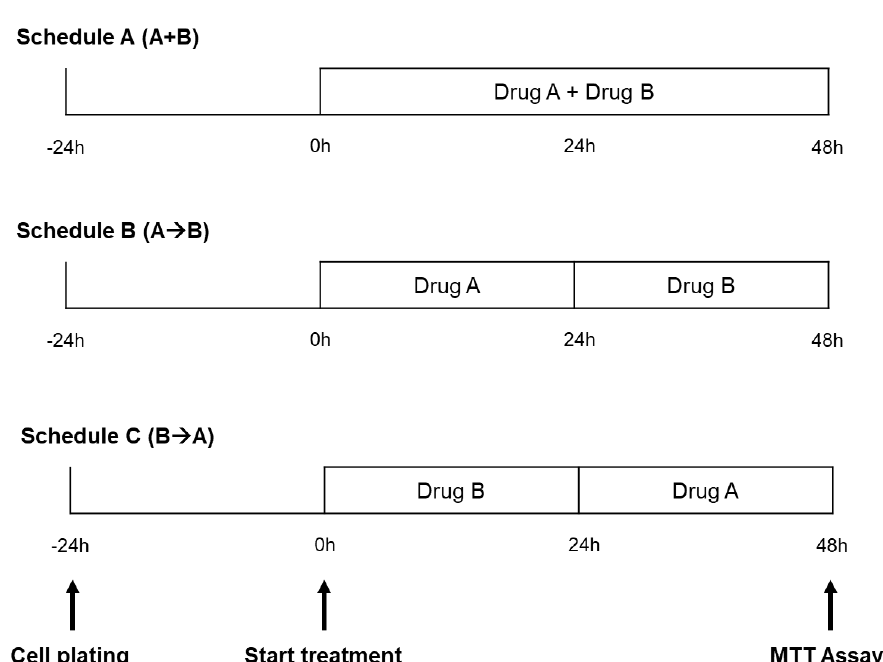
Figure 11. The three combination schedules designed for evaluating 5-FU combination with fluphenazine, fluoxetine, benztropine and artesunate. Schedule A represents cells treated concomi- tantly with 5-FU and each repurposed drug for 48 h. Schedule B represents cells pre-treated with 5-FU for 24 h followed by each repurposed drug for another 24 h. For schedule C, cells were pre-treated with each repurposed drug for 24 h, followed by 5-FU for another 24 h.